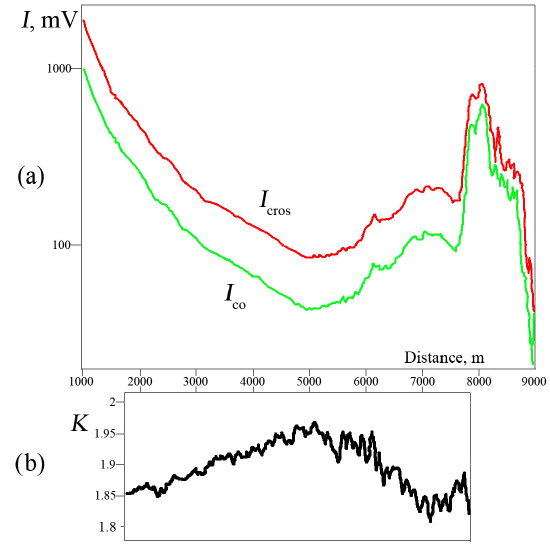
Figure 7. Channel calibration procedure. (a) The record of a signal (1064nm) integrated by the plate rotation angle, with components I co (green) and I cros (red). Integration was carried out during four revolutions of the plate. (b) The value of calibration constant K , calculated in the height range of 1800–8000m. The mean value is K = 1 .